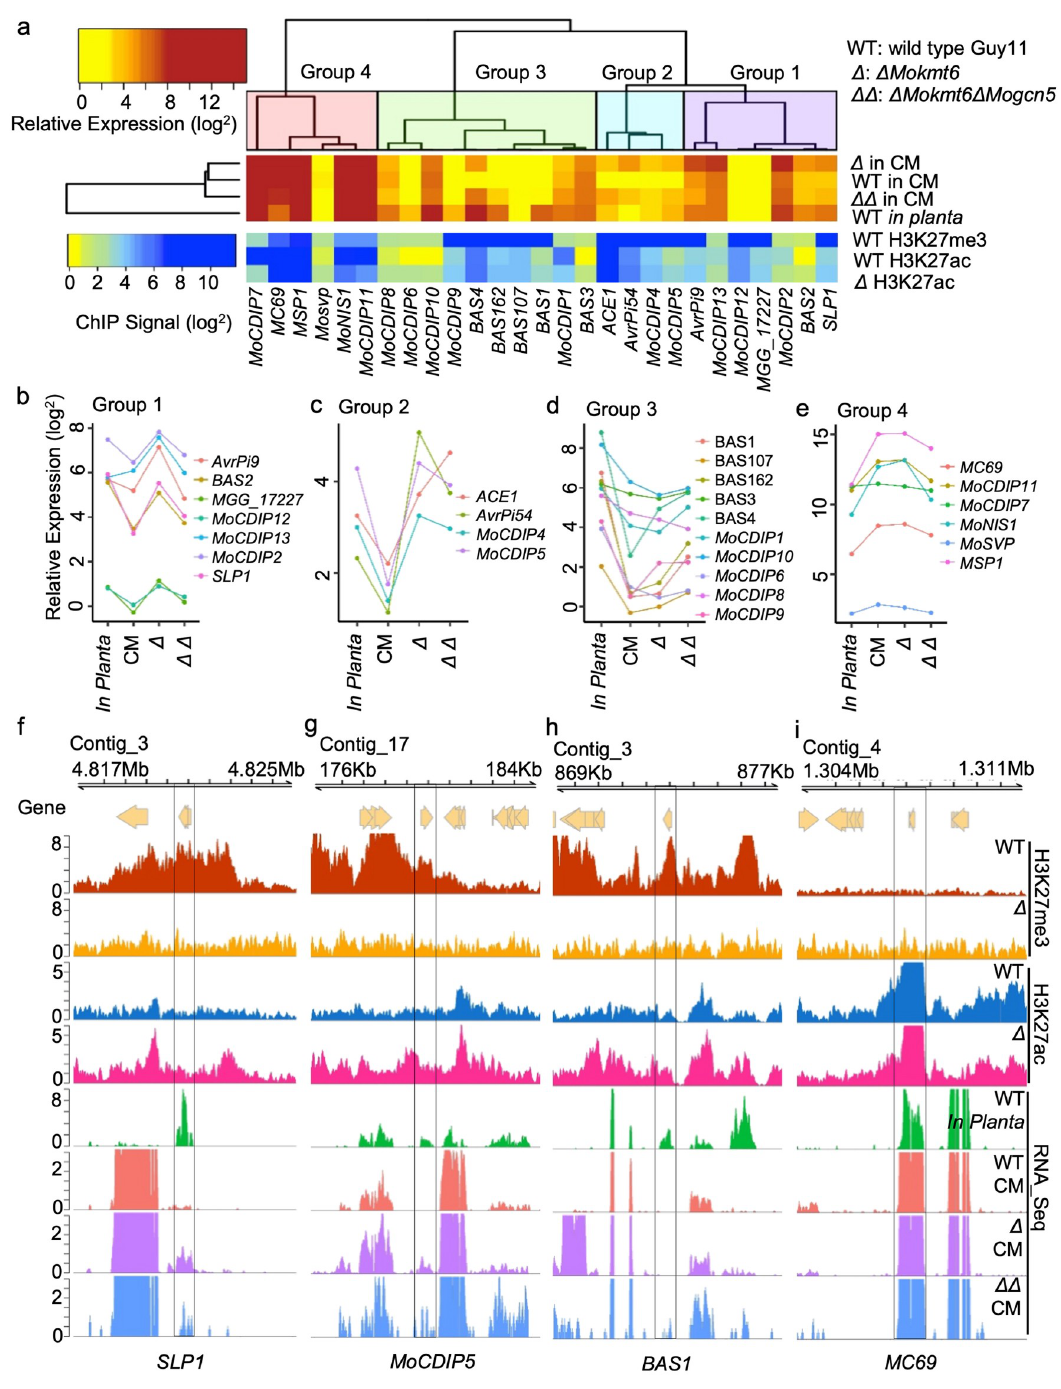
Fig 6. Fungal effector genes are regulated in H3K27me3-dependent and -independent manners. (A) The heatmap (top) identifying four groups of 27 characterized effector genes based on their gene expression pattern across three genotypes growing either in vitro complete medium (CM) or in planta . The heatmap (bottom) showing the status of H3K27me3 and H3K27ac for all effector genes under the same experimental condition as their gene expression. The effector gene expression data were collected by RNA-seq from Guy11 wild type (WT) growing either in vitro complete medium or in planta , and single deletion mutant Δ Mokmt6 ( Δ ) and double deletion mutant Δ Mokmt6 Δ Mogcn5 ( ΔΔ ) growing in complete medium. The Δ Mokmt6 lacks H3K27me3 and Δ Mokmt6 Δ Mogcn5 lacks H3K27me3 and majority of H3K27ac. (B) to (E) showing the expression pattern of effector genes in each group. (F) to (I) showing the profiles of ChIP-seq reads (bins per million mapped reads, BPM) for H3K27me3 and H3K27ac, and RNA-seq reads (BPM) at specific effector gene loci from each of the four groups.